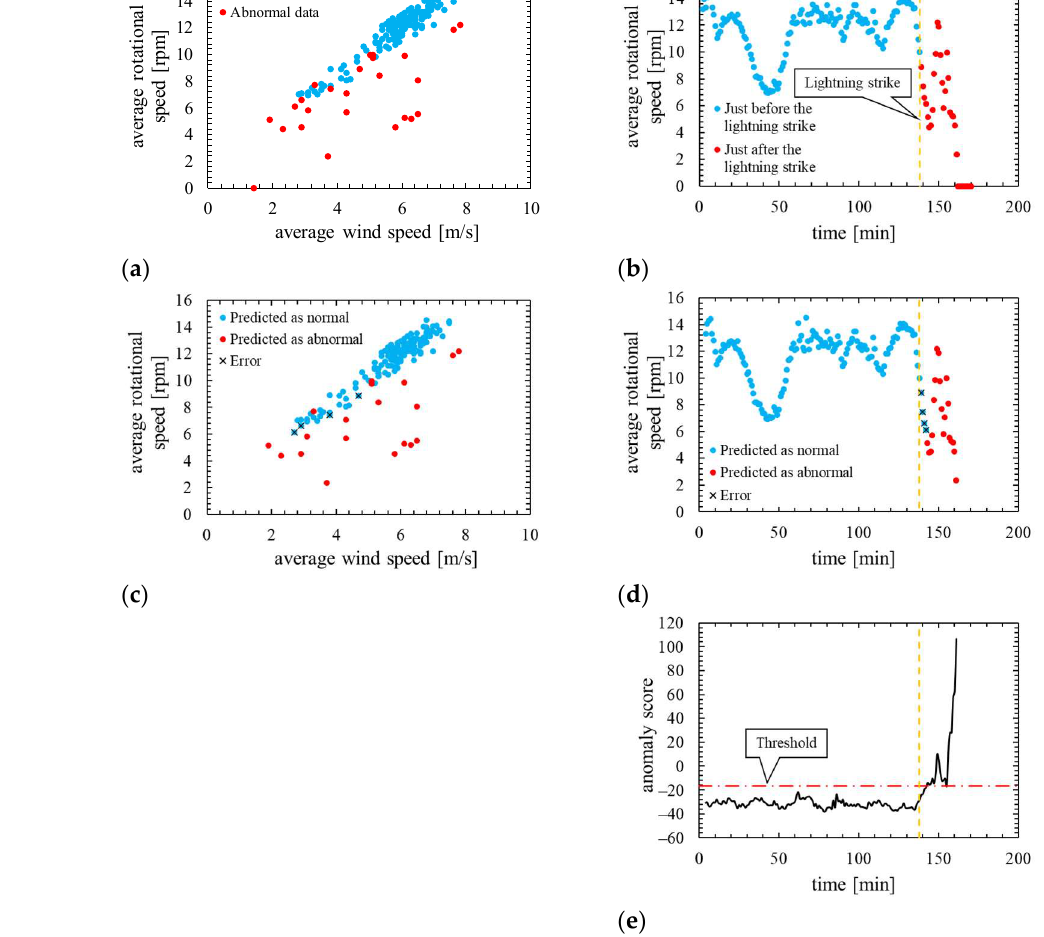
Figure 11. True label and assessment result of the model in which the number of mixture components K was 128 (the threshold is the 100th percentile’s value): ( a ) wind speed rotational speed characteristic with true label; ( b ) time characteristics of rotational speed with true label; ( c ) wind speed-rotational speed characteristic with predicted label; ( d ) time characteristics of rotational speed with predicted label; ( e ) time characteristics of anomaly